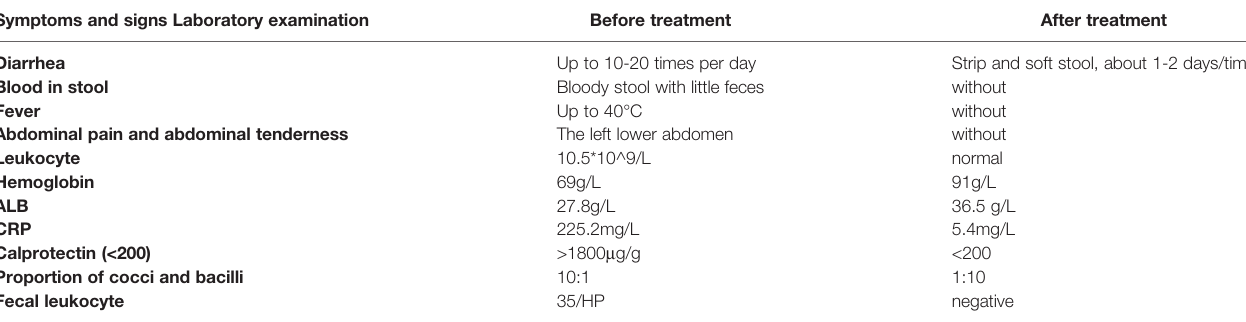
TABLE 1 | Comparation of symptoms, signs and laboratory examination before and after